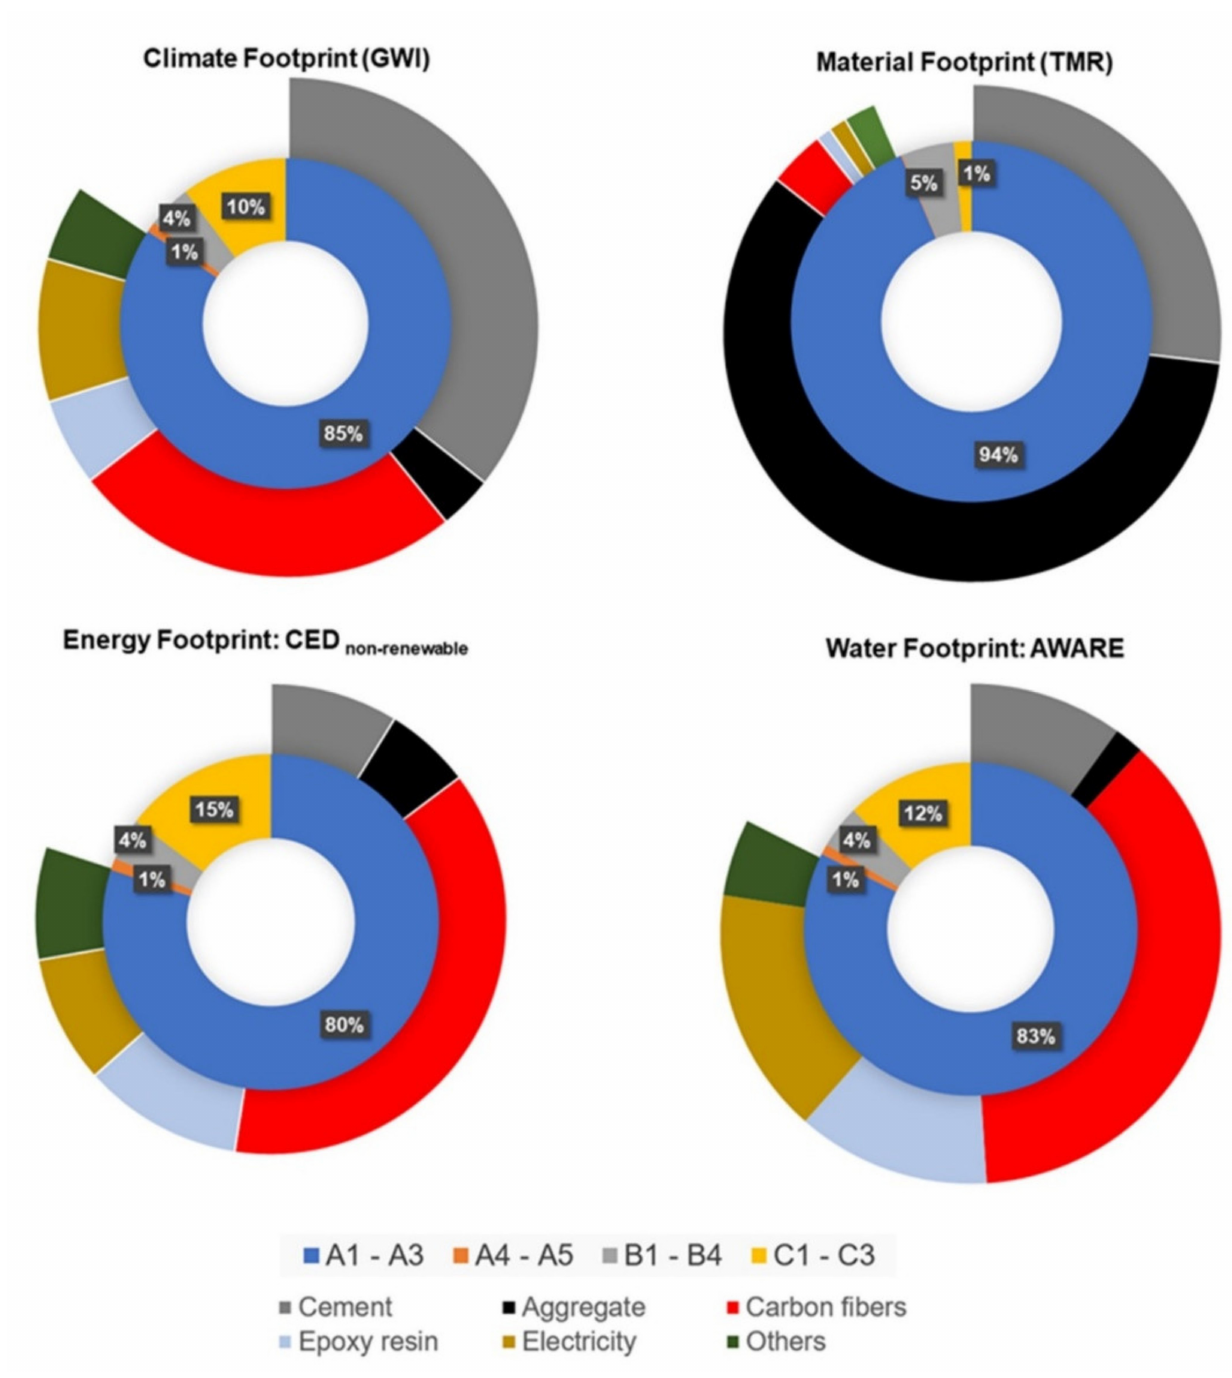
Figure 2. Share of climate, material, energy and water footprints of carbon concrete (CC), GWI: global warming impact, TMR: total material requirement, CED: cumulated energy demand, AWARE: available water remaining. A1-A3: production phase, A4-A5: construction phase, B1-B4: use phase, C1-C3: end-of-life